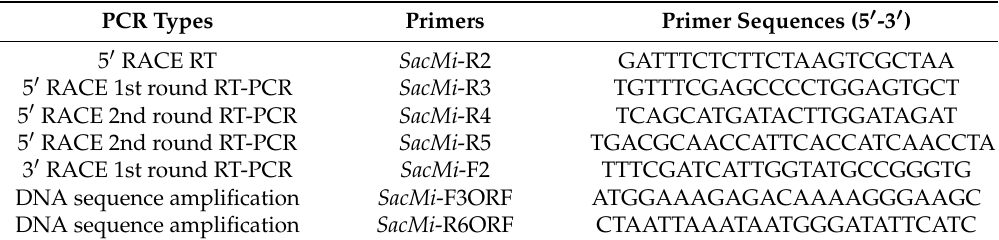
Table 1. Primer sequences used in the study to isolate the SacMi